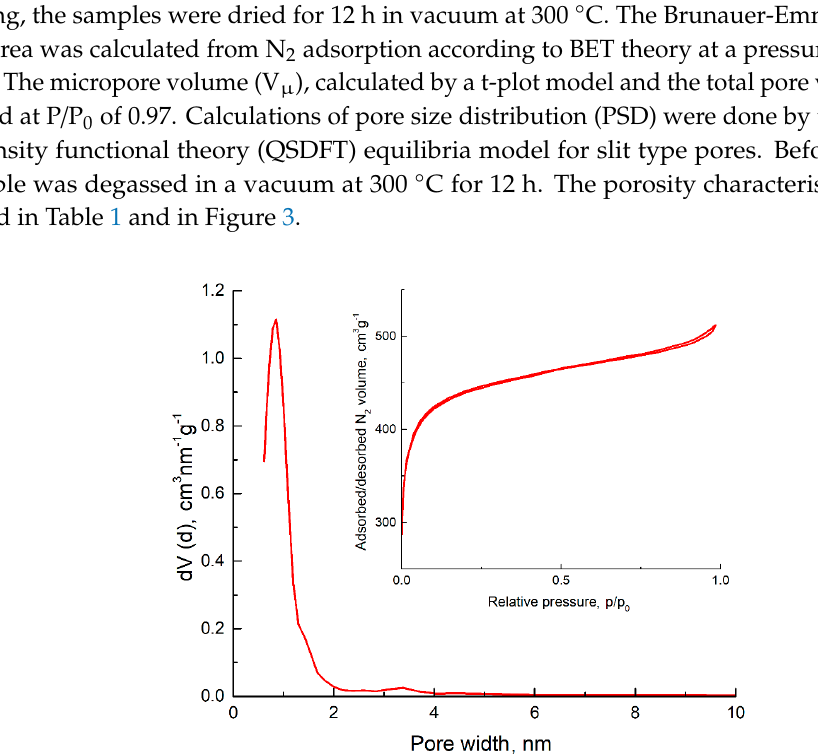
Figure 3. The pore size density (PSD) and N 2 absorption/desorption isotherm of tested CDC samples.